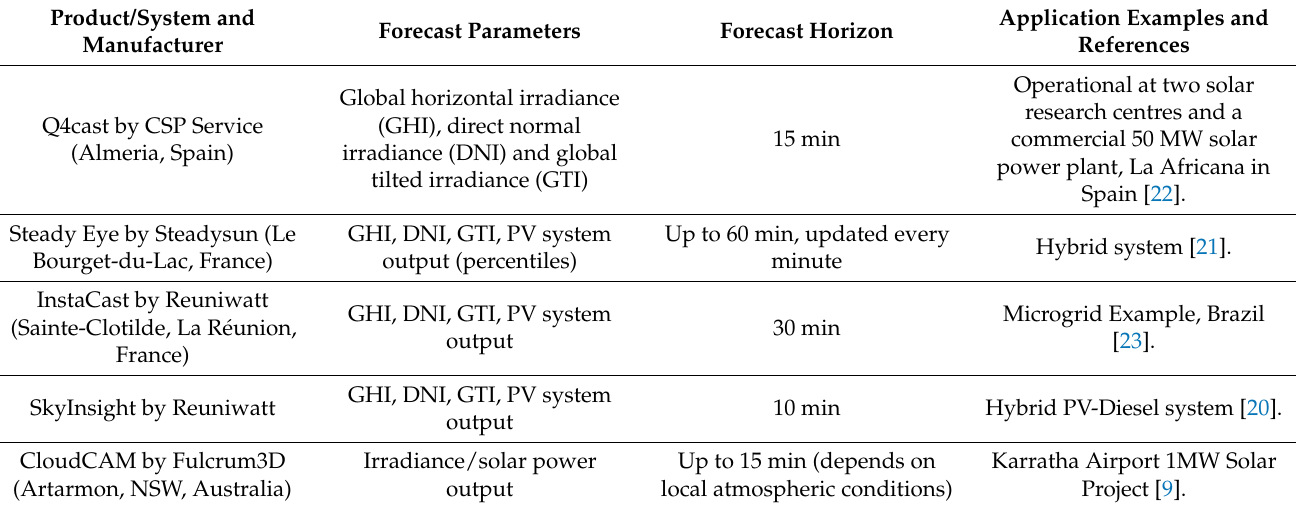
Table 1. Nowcasting tool